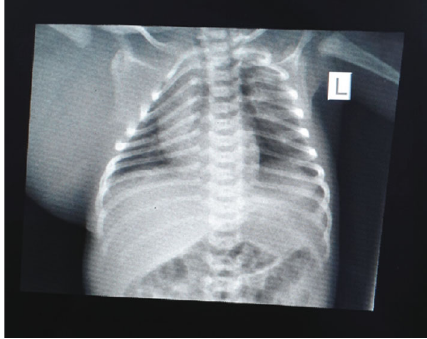
Figure 2: Plain chest X-ray showing homogenous soft tissue lesion left axillary region.